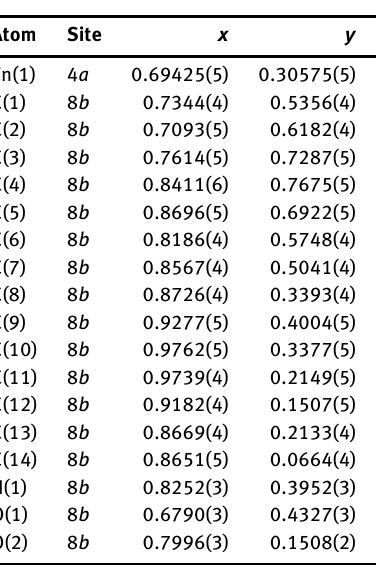
Table 3: Fractional coordinates and atomic displacement parameters (Å 2